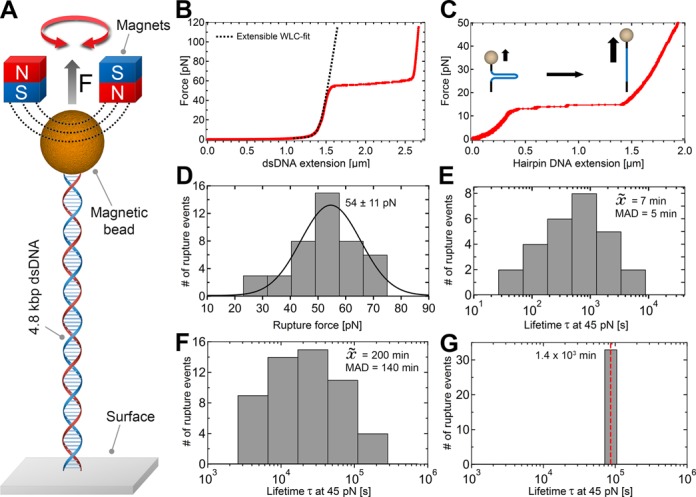
DNA stability under high forces. (A) DNA tethers were stretched by applying a magnetic field via a pair of superparamagnetic magnets. (B) Force-extension plot for a covalently anchored linear 4.8 kbp dsDNA tether. The black dashed line is a fit of the extensible worm-like-chain fit to the data. At ∼60 pN, the overstretching transition of DNA is observed. (C) Force-extension plot for a covalently surface-bound single 1 kbp hairpin DNA construct. (D) Histogram of measured rupture forces (n = 43) via DFS with constant loading rate of 10pN/s up to 150 pN and applied Gaussian fit (black curve). (E) Histogram of measured lifetimes at constant pulling force of 45 pN (n = 37) for dsDNA tethers anchored via DIG:anti-DIG to the surface and streptavidin:biotin to the magnetic bead. (F and G) Histograms of observed lifetimes at applied forces of 45 pN for DNA molecules anchored covalently to the surface alone (n = 52) (F) and anchored covalently to both surface and bead (n = 32) (G). The median of tether lifetimes in (E and F) is denoted within the histogram panels as \documentclass[12pt]{minimal}
\usepackage{amsmath}
\usepackage{wasysym}
\usepackage{amsfonts}
\usepackage{amssymb}
\usepackage{amsbsy}
\usepackage{upgreek}
\usepackage{mathrsfs}
\setlength{\oddsidemargin}{-69pt}
\begin{document}
}{}$\tilde X$\end{document} with the corresponding median absolute deviation (MAD). The red dashed line in (G) is meant to indicate that the measured lifetimes are lower bounds, as the experiment itself was terminated after 24 h.